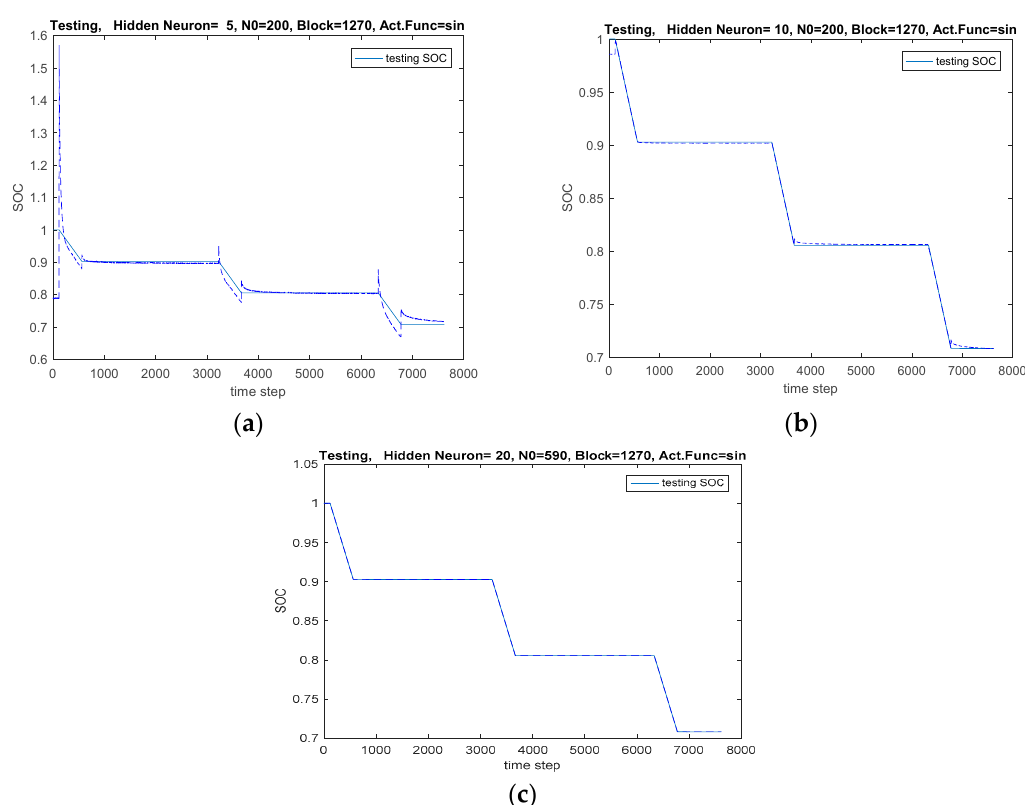
Figure 15. SOC testing performance of online sequential ELM at 25 °C ambient temperature (for different neuron numbers). ( a ) 5 neurons, ( b ) 10 neurons, ( c ) 20 neurons.